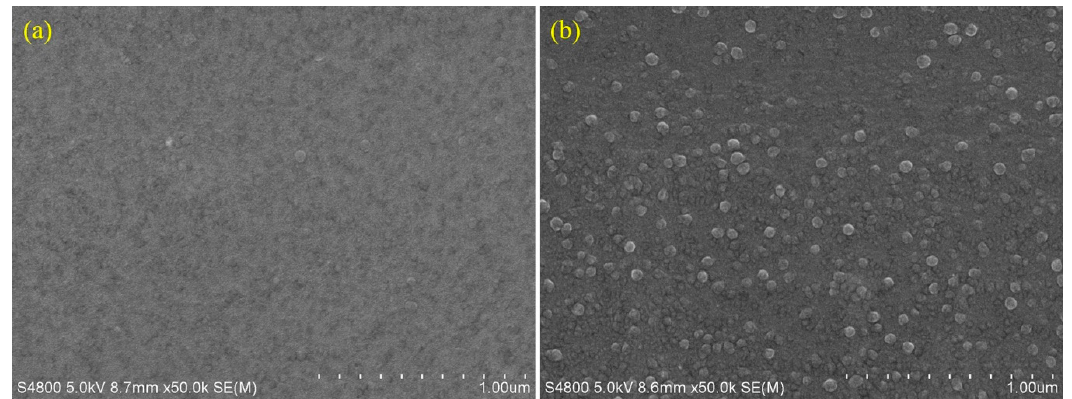
Figure 1. SEM micrographs of the PIMs. ( a ) PIM4; ( b ) PIM6.